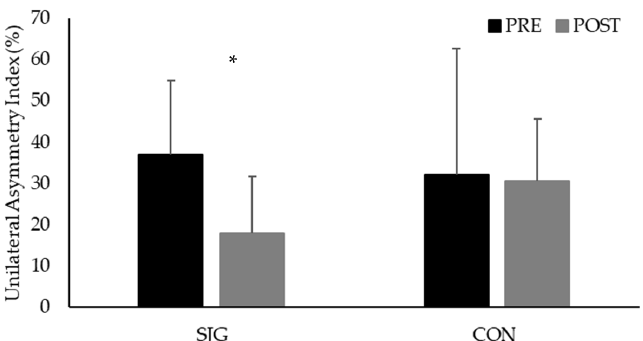
Figure 2. Means and standard deviations of Unilateral Asymmetry Index between SuperJump ® (SJG) and Control (CON) groups before (PRE) and after (POST) the training session. * significantly differences for SuperJump ® group between testing time.